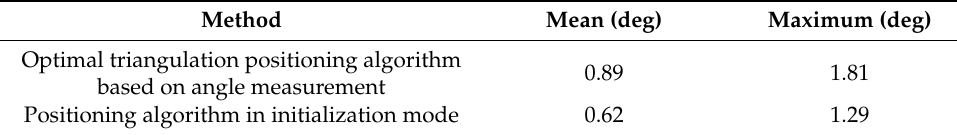
Table 6. The comparison in orientation